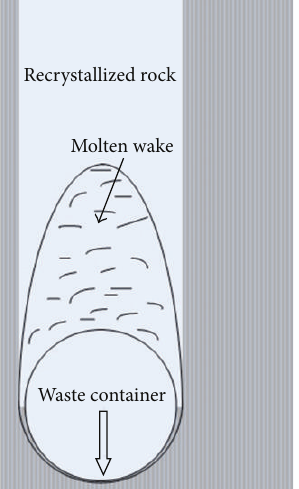
Figure1:Self-burialprocessofaradioactivewastecontainerbydeep rock melting.